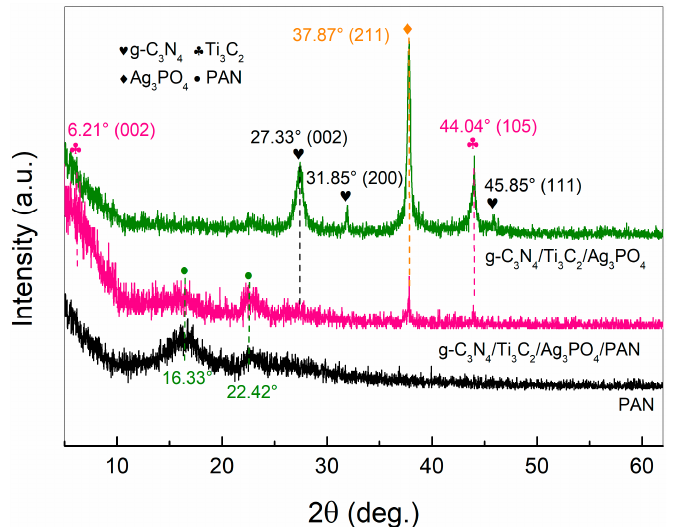
Figure 2. The XRD pa tt ern of PAN, g-C 3 N 4 /Ti 3 C 2 /Ag 3 PO 4 and g-C 3 N 4 /Ti 3 C 2 /Ag 3 PO 4 /PAN.